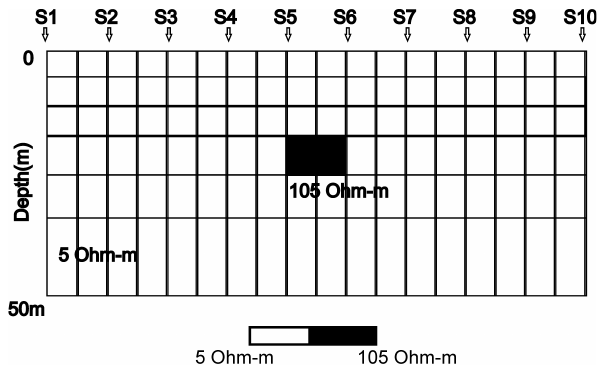
Fig. 4. Forward model used to create the resistivity synthetic train- ing and testing for two-dimensional resistivity